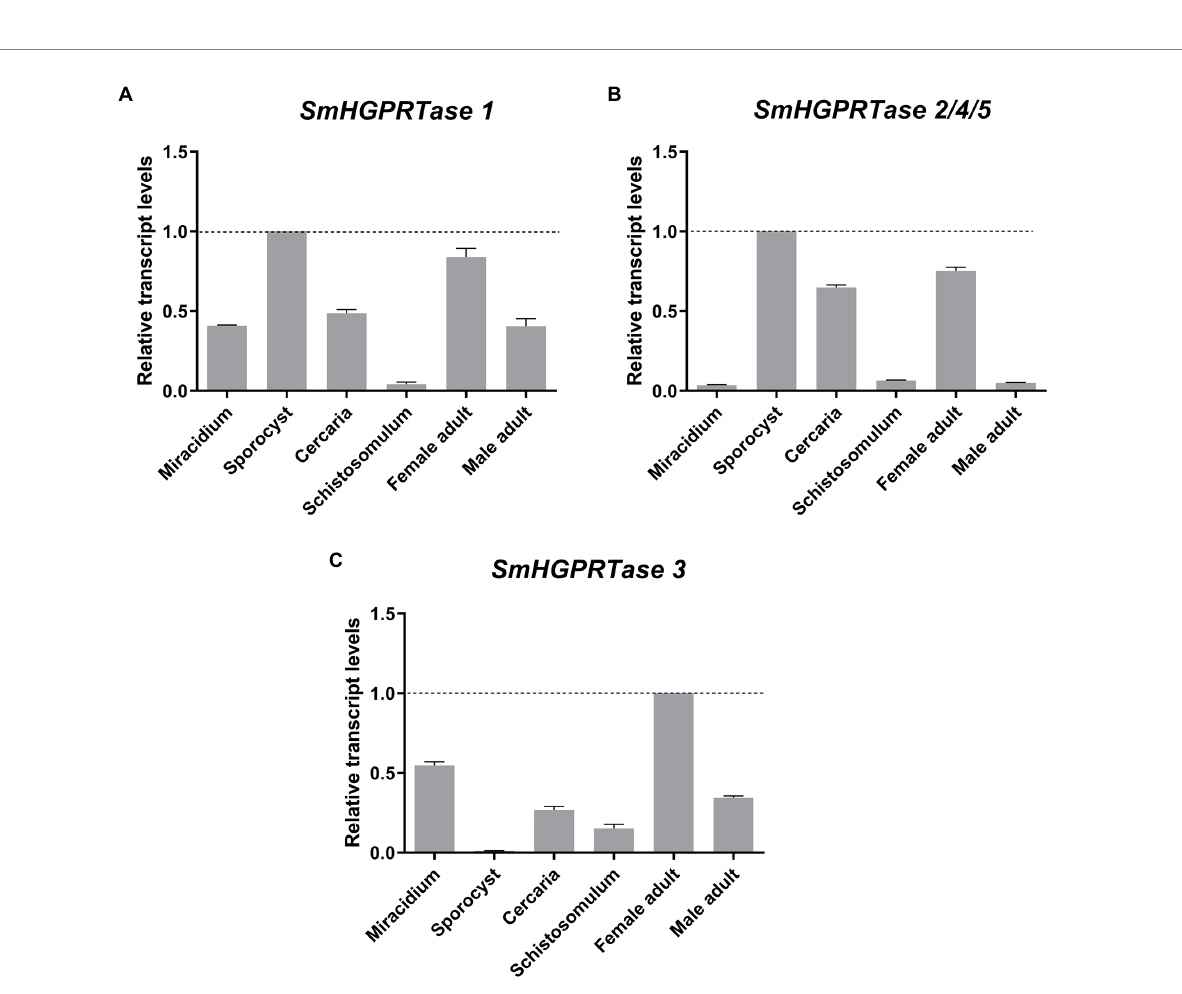
FIGURE 4 Expression profile of SmHGPRTases throughout different parasite’s life stages. Bars showing the relative transcript levels of SmHGPRTase 1 (A) , SmHGPRTase 2/4/5 (B) , and SmHGPRTase 3 (C) in the different S. mansoni life stages: miracidium, sporocyst, cercaria, schistosomulum, male, and female adult worm. (A,B) Data were normalized relative to the sporocyst stage (dashed line). (C) Data were normalized relative to the female adult worm stage (dashed line).